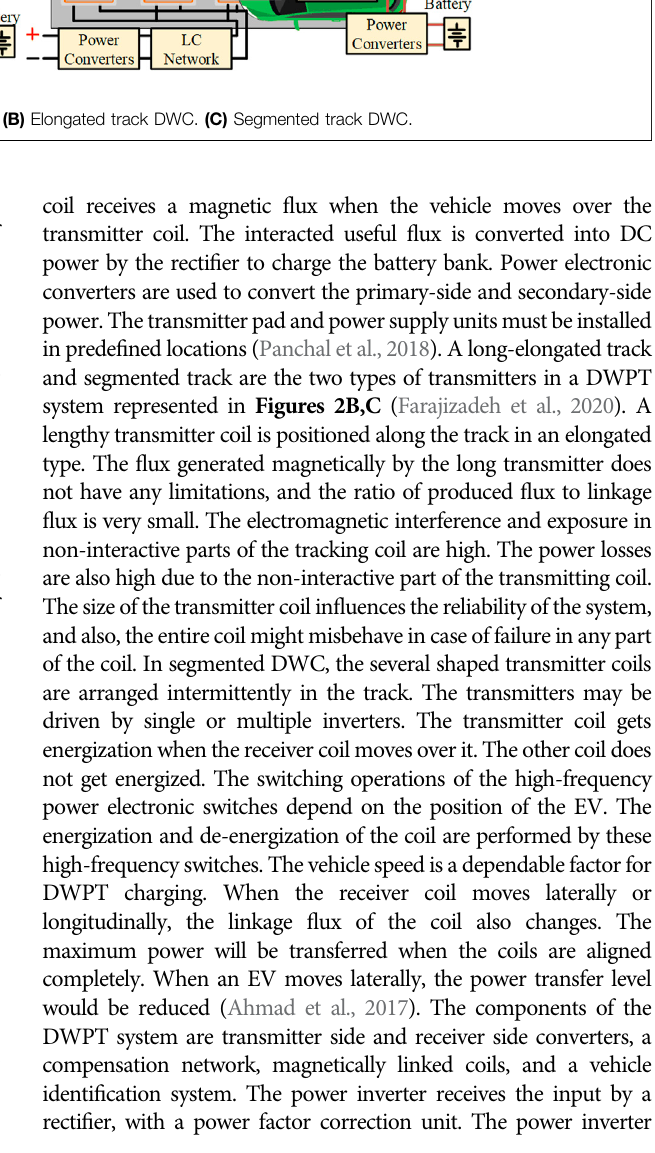
FIGURE 2 | (A) Basic representation of the microgrid-integrated DWC system. (B) Elongated track DWC. (C) Segmented track